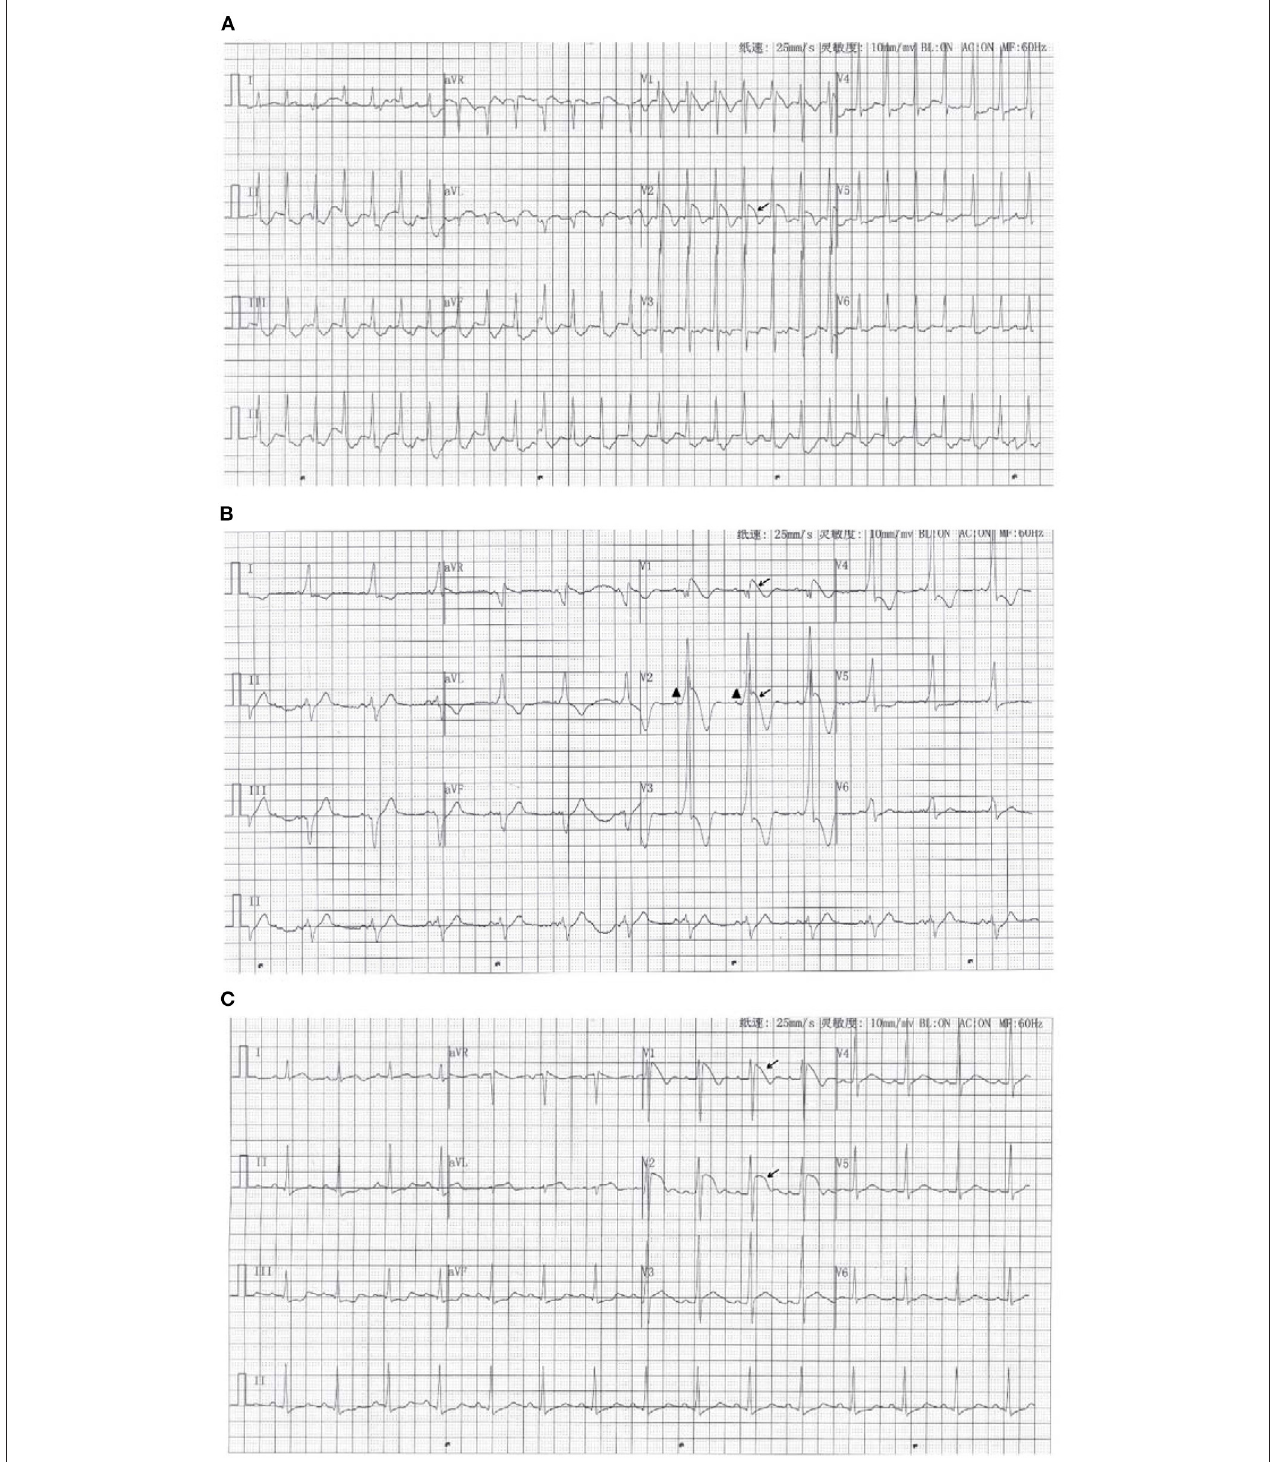
FIGURE 1 | (A) The ECG recorded in the emergency room when the patient felt palpitations. It showed the coexistence of paroxysmal supraventricular tachycardia and the Brugada pattern (arrow) on one ECG. (B) The ECG with the delta wave (Triangle mark) and Brugada pattern (arrow). (C) The ECG with only the Brugada pattern